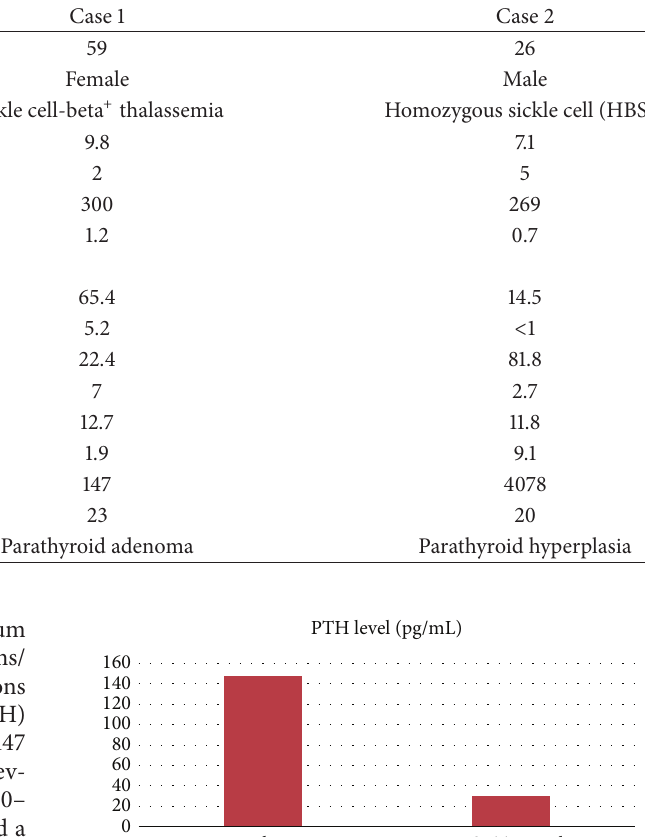
Table 1: Hb: hemoglobin, HPLC: high performance liquid chromatography, HbS: sickle cell hemoglobin, HbF: fetal hemoglobin, HbA and HbA2: adult hemoglobin, and PTH: parathyroid hormone.